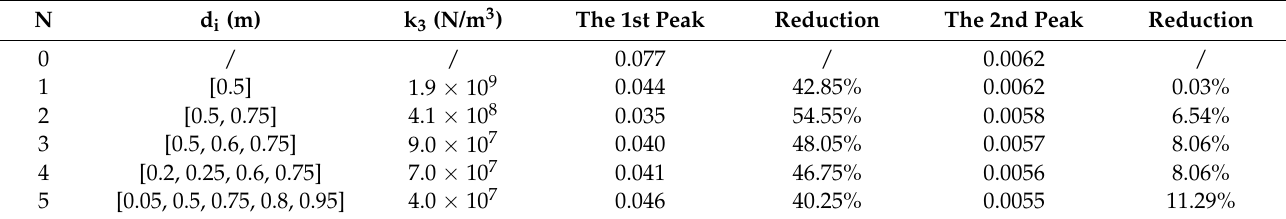
Table 4. Comparison of the performance between different numbers of NESs.